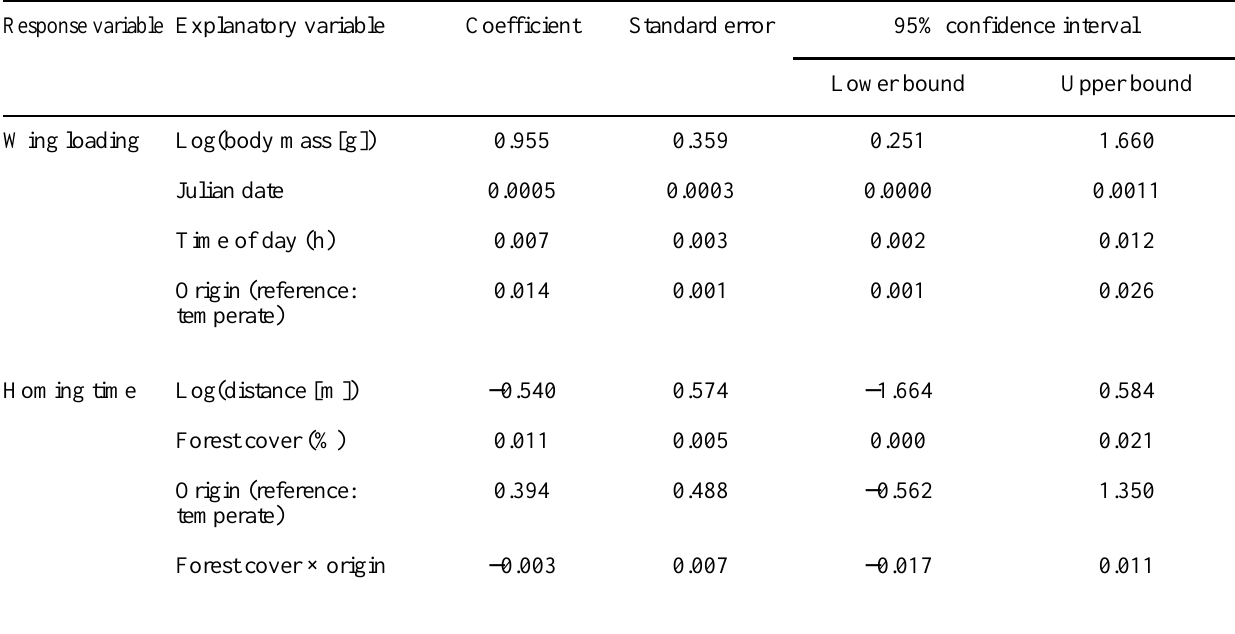
Table 3. Multimodel inference based on the generalized linear models and the Cox proportional hazards regression models used to assess the influence of an Ovenbird’s origin on log-transformed wing loading and homing time of translocated individuals,